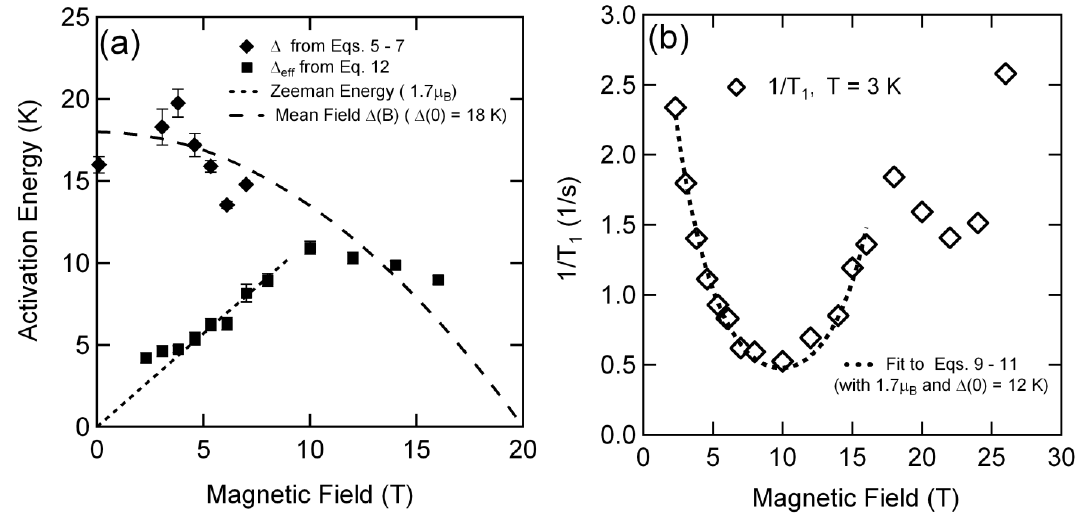
Figure 10. ( a ) Effective gap parameters for Per and susceptibility analysis. Error bars represent uncertainties in fitting parameters for specific data sets. Overall uncertainties between fits to all data sets, which are significantly larger, are manifested by the scatter in the fit parameters; ( b ) Spin-relaxation rates